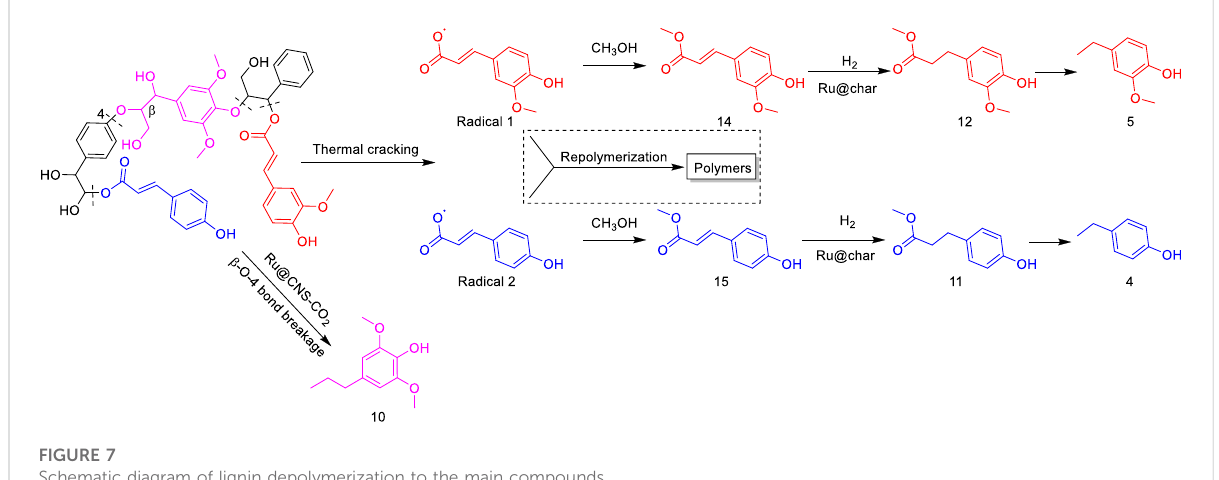
FIGURE 7 Schematic diagram of lignin depolymerization to the main